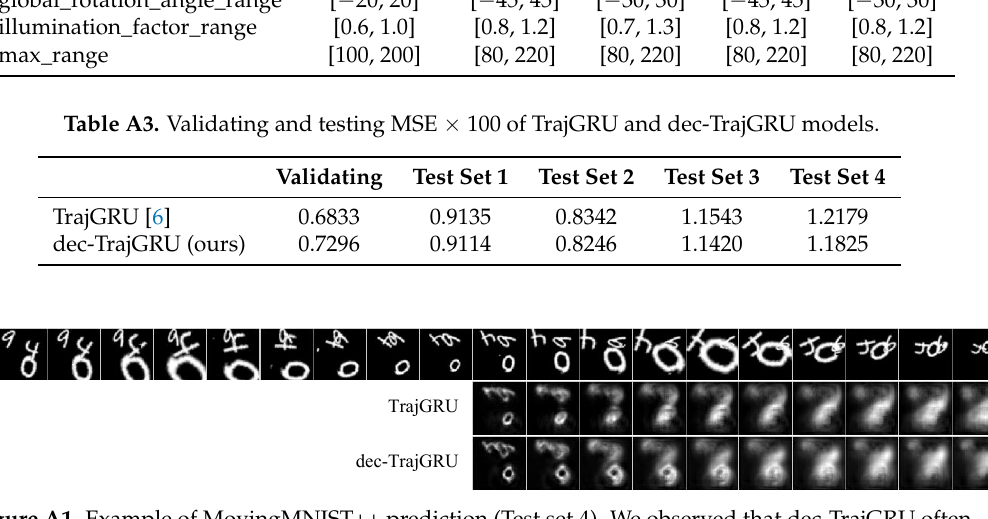
Figure A1. Example of MovingMNIST++ prediction (Test set 4). We observed that dec-TrajGRU often made less wrong assumption when going further into the